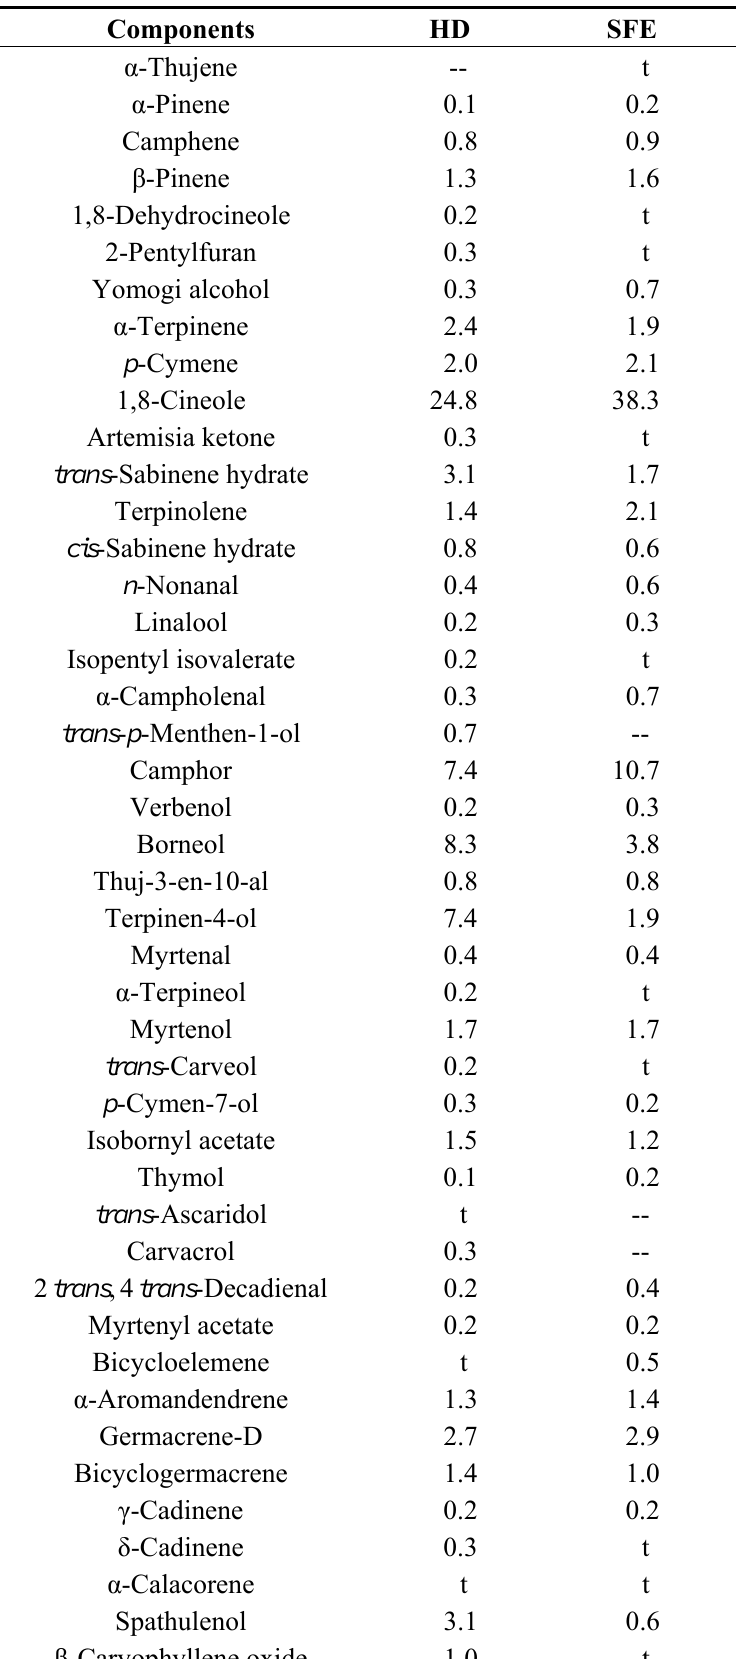
Table 4. Percentage composition of cotton lavender oils obtained by HD and SFE, in the conditions report in Table 1